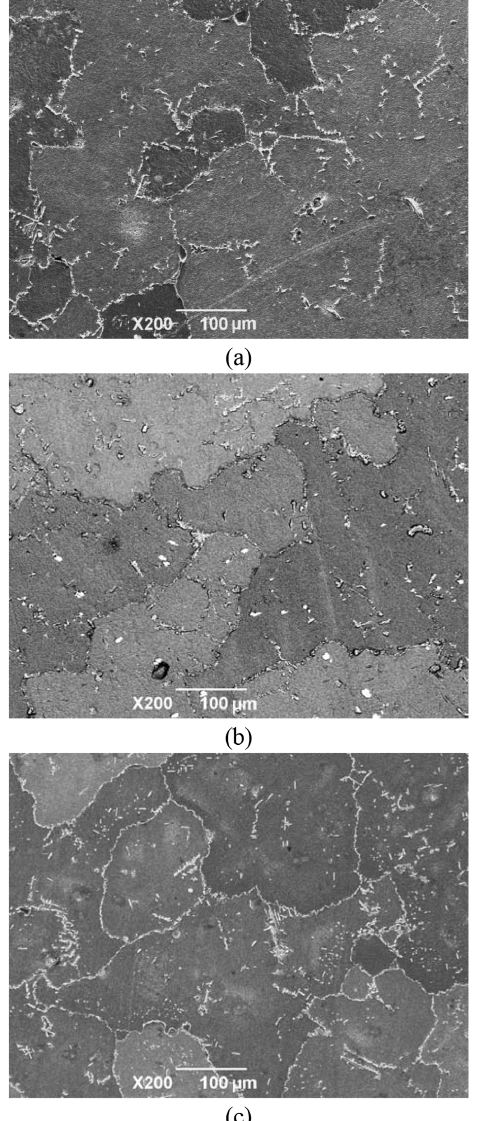
Figure 3: morphology of carbides at grain boundaries in non-HIPed and HIPed specimens: (a) Cas; (b) H35 and (c)